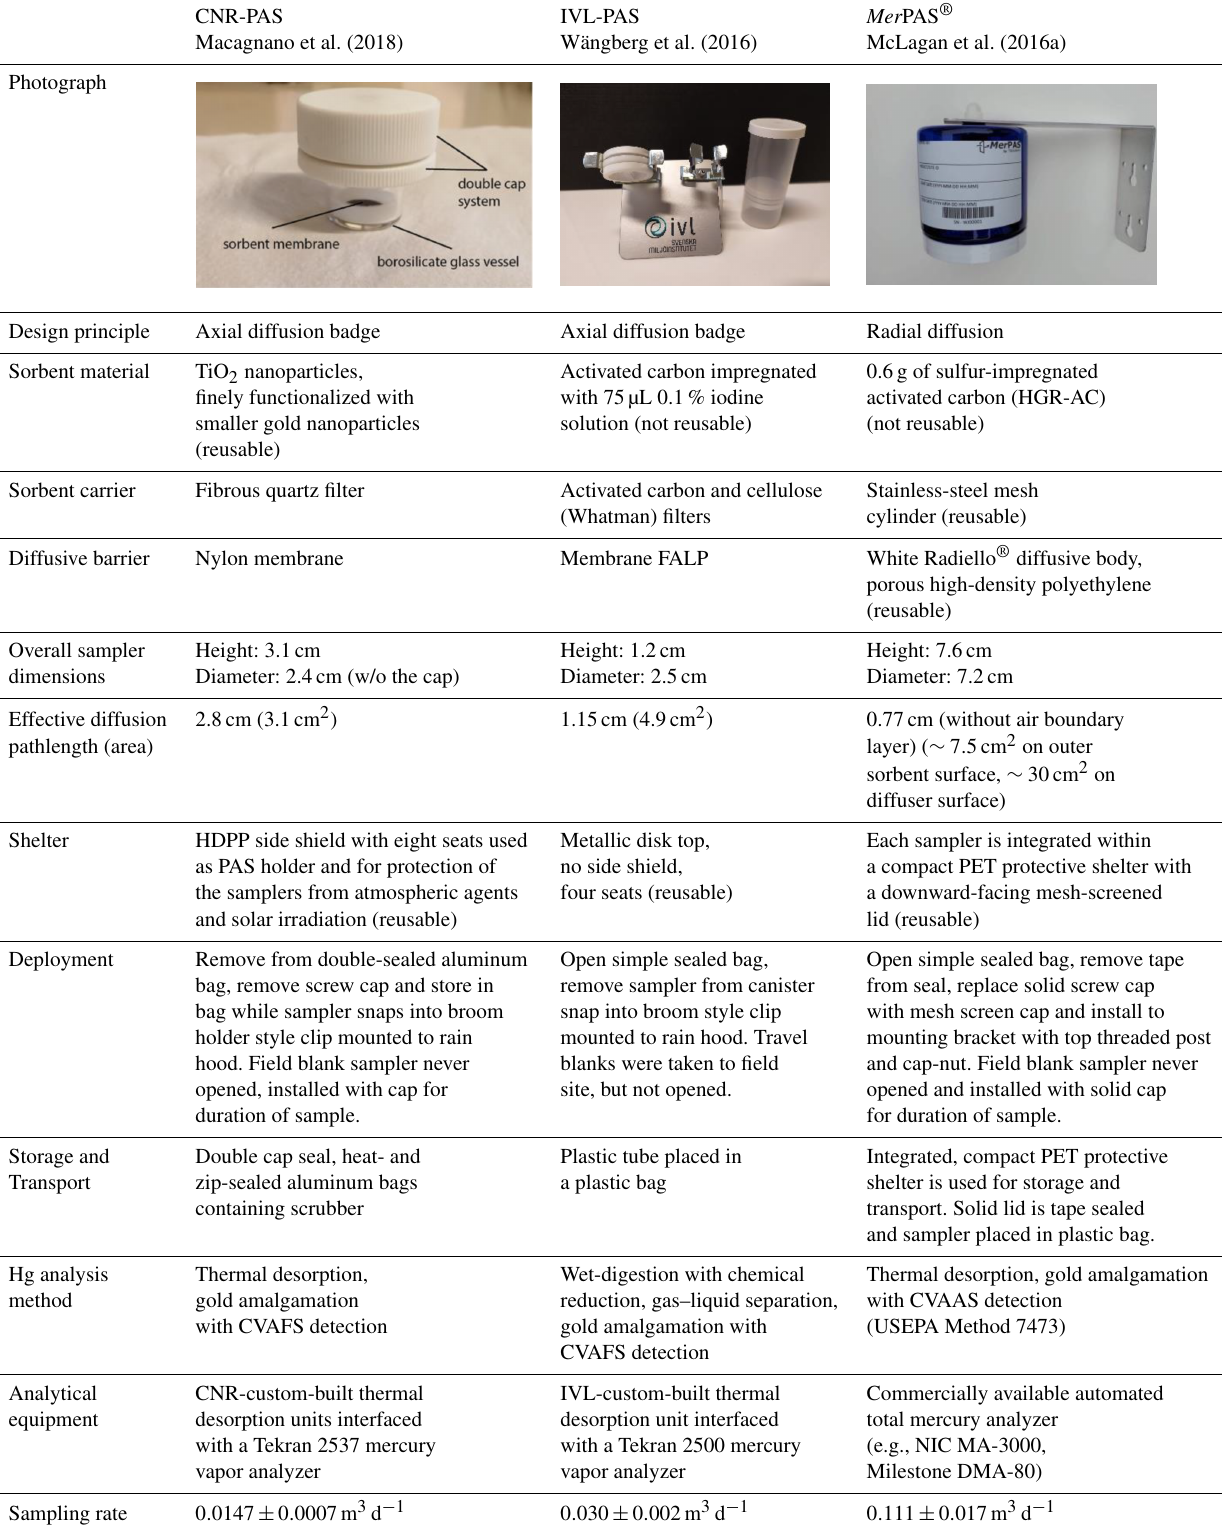
Table 1. Characteristics of the three passive air samplers for gaseous mercury that were compared in this